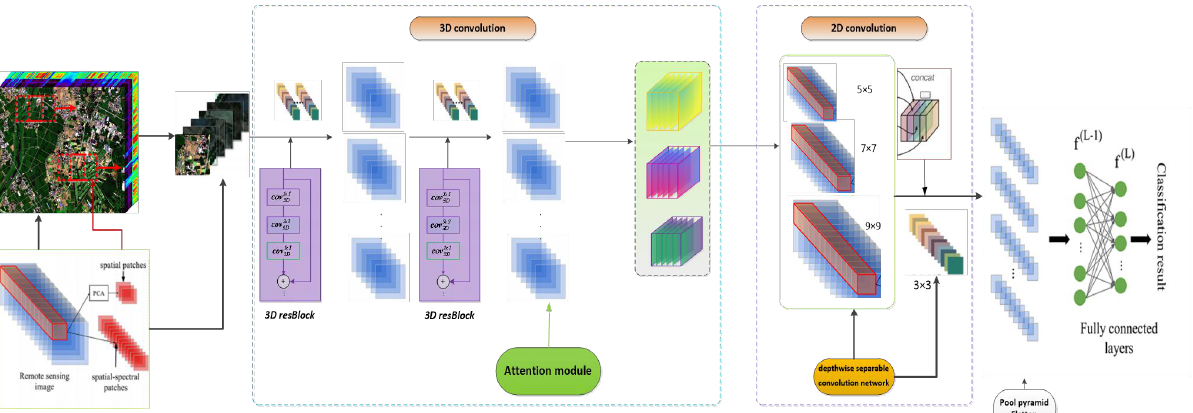
Figure 2 . The proposed network